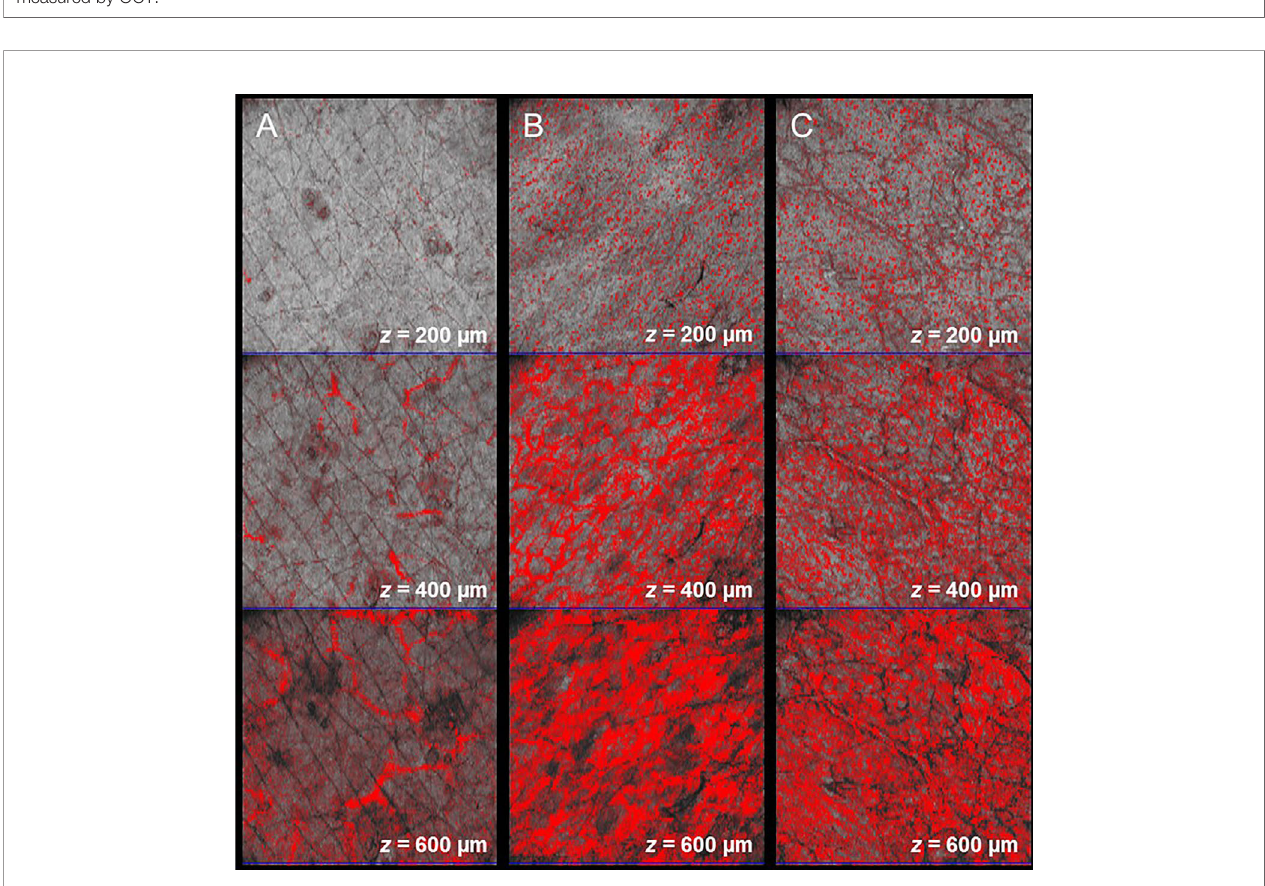
FIGURE 9 | Angiographic OCT allows the visualization of elongated capillary loops in the super fi cial papillary dermis and the underlying vessel plexus. In comparison to the healthy control (A) , changes of vascular pattern, vessel diameter, depth, and density can be observed in lesional skin in atopic dermatitis (B) and in plaque psoriasis (C)